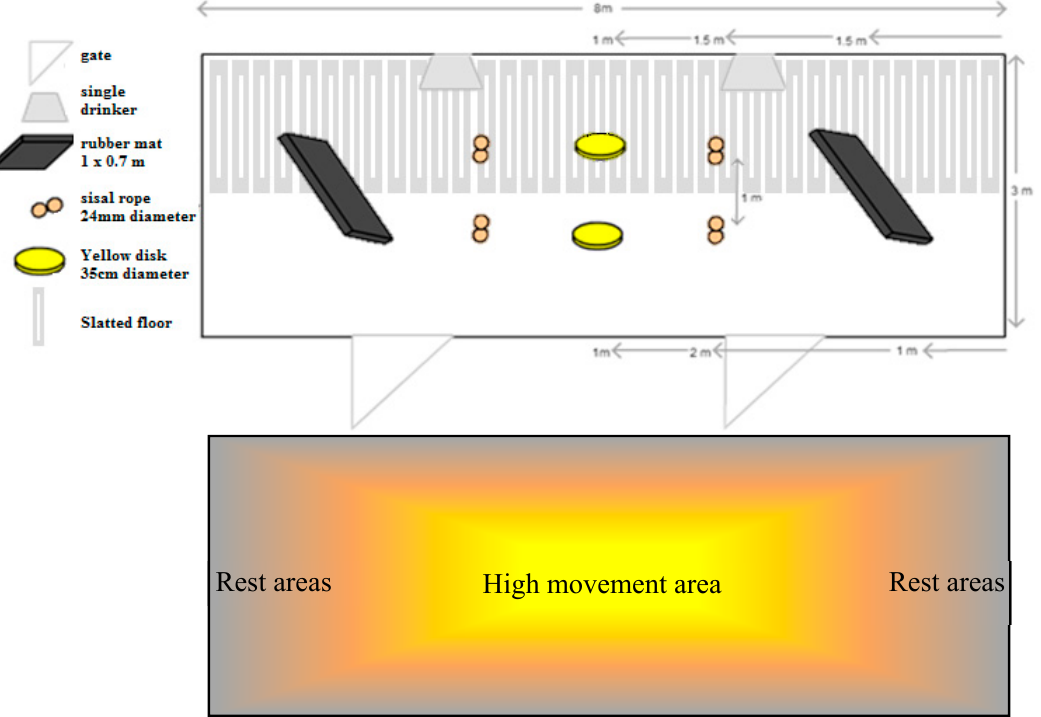
Figure 1. Placement of point-source materials suspended from the roof (rope, yellow disk swings and rubber mats) in the enhanced treatment pen, which housed 12 gestating sows from the point of mixing, after insemination, until pregnancy check, at a space allowance of 2 m 2 /sow. Also, a map explaining the placement of point-source materials based on predicted animal movements within the pen.